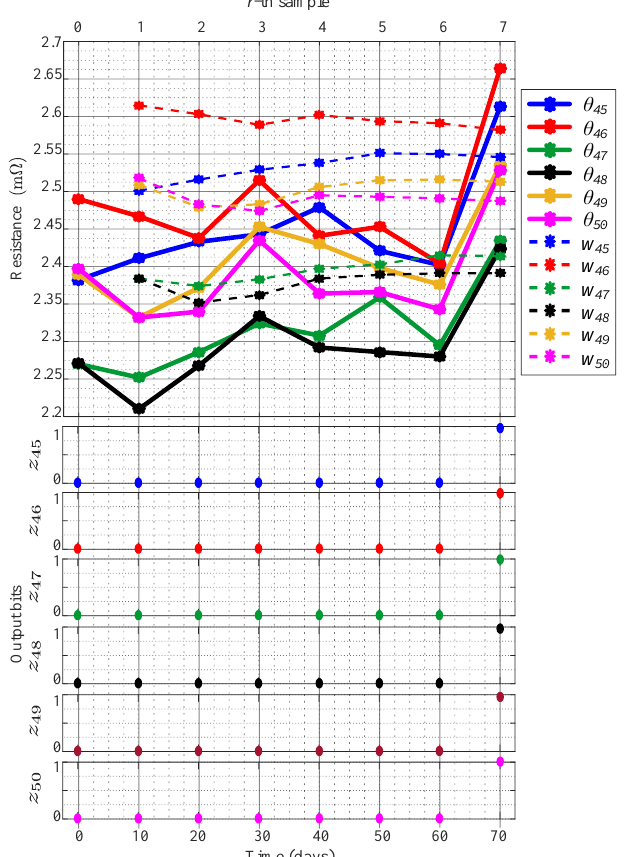
Figure 9. Experimental evaluation of the ohmic resistance where low electrolyte level is detected at day 70 when the eighth sample was